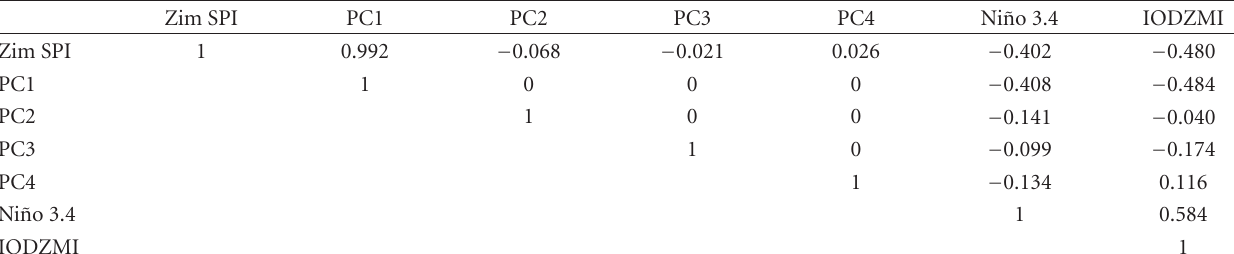
Table 2: Contingency table for the cross-correlation among variables used in the study.